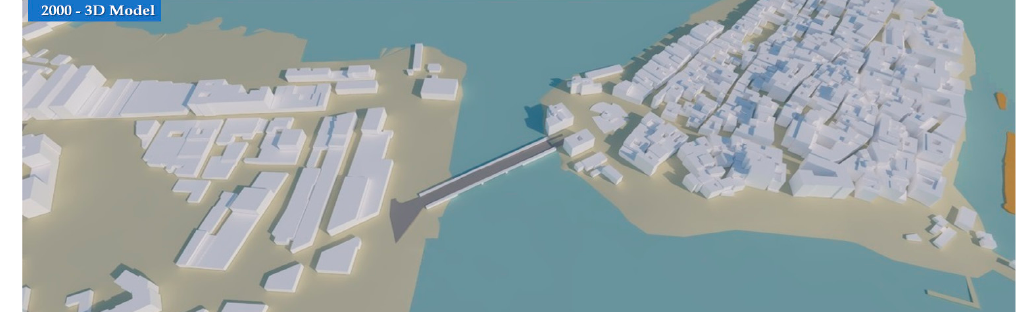
Figure 14. 3D models of the year